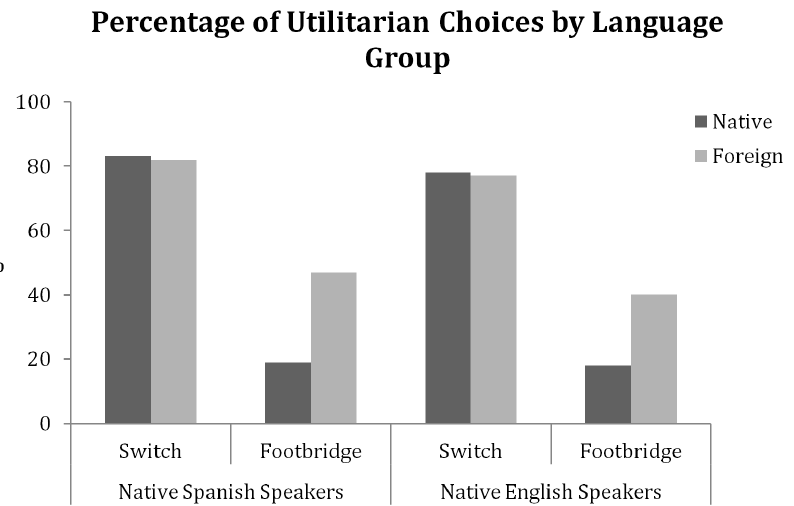
Figure 2. Percentage of utilitarian decisions by language group (Experiment 2). Percentage of utilitarian decisions for the two versions of the trolley problem in the native language condition and the foreign language condition, divided by native language group. Native Spanish speakers using Spanish (N=200) or English (N=197); native English speakers using English (N=168) or Spanish (N=160).